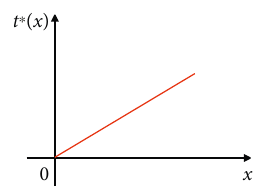
Figure 4: Optimal emotional output t ∗ ( x ) .